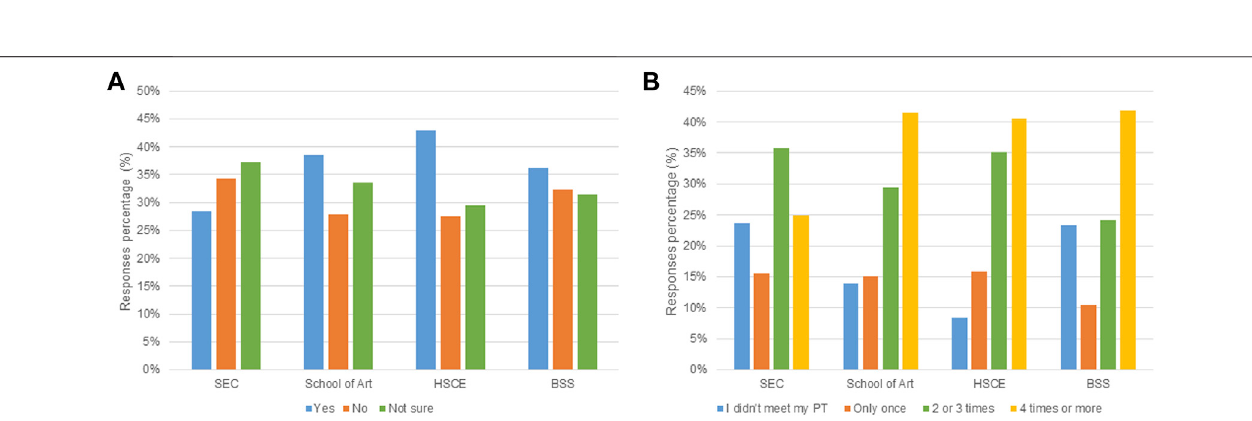
FIGURE3| Frequency ofmeetings withaPersonalTutor(PT)basedon Faculty/course group (A) ,Compulsorynature ofPersonalTutor (PT)meetingsperFaculty/ course group (B) .